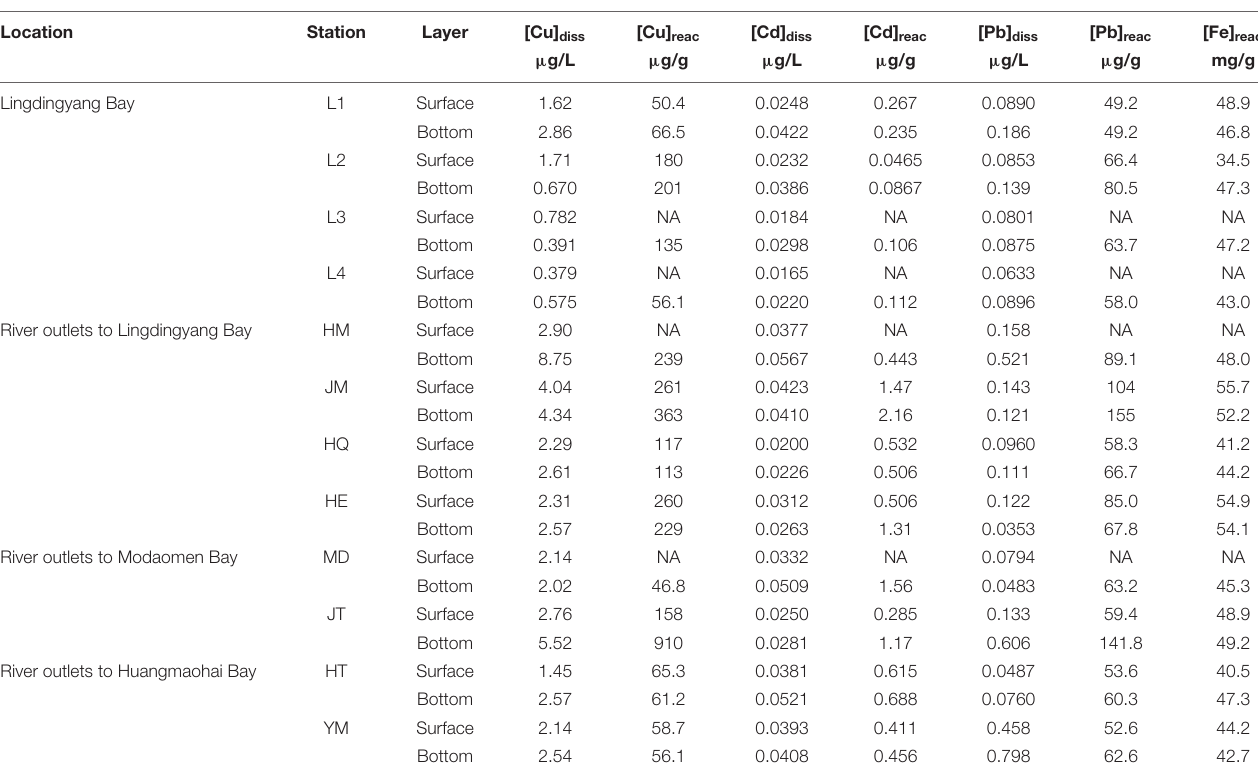
TABLE 3 | Concentrations of Cu, Cd, Pb in dissolved and reactive phases of all samples.